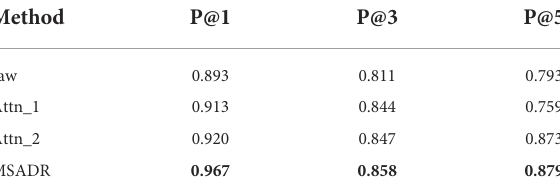
TABLE 5 Recommendation comparison of ablated models trained using leave-one-out cross-validation on the entire dataset.